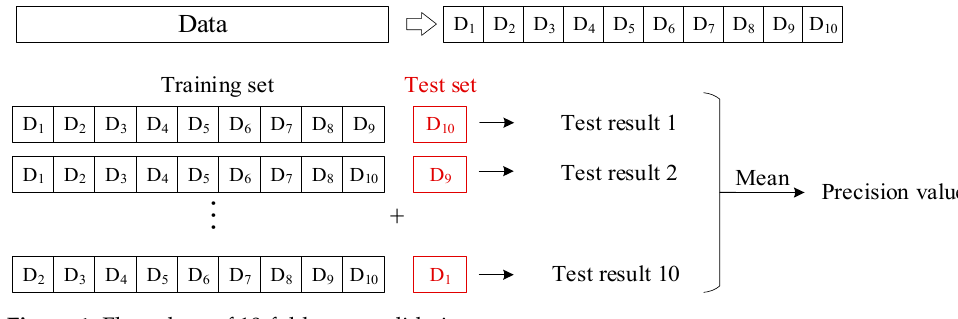
Figure 1. Flow chart of 10-fold cross-validation .